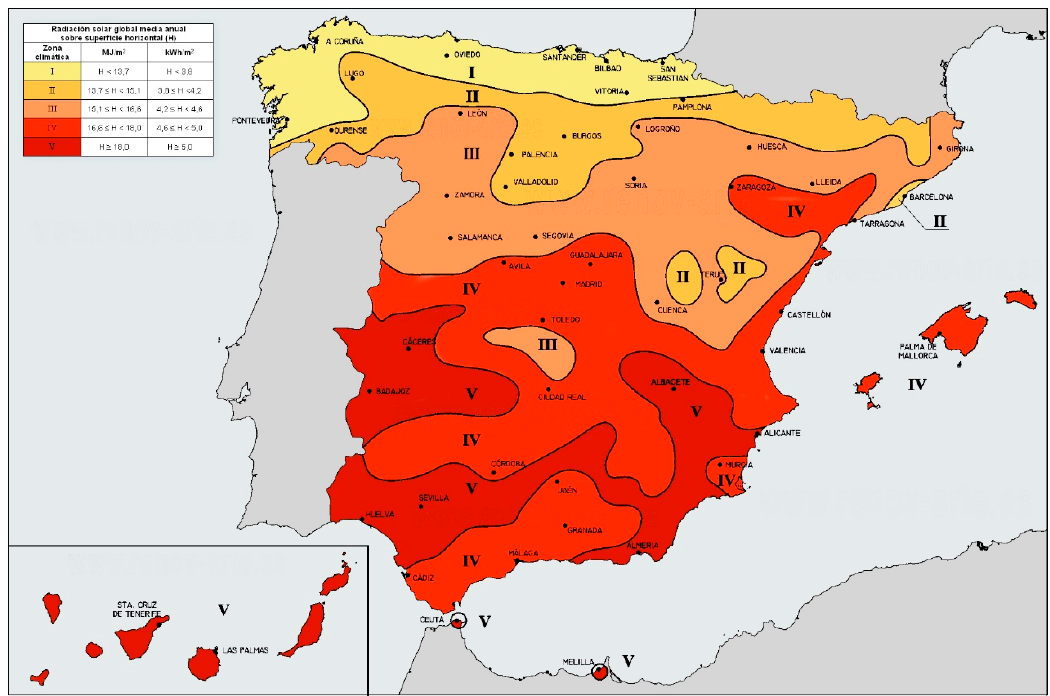
Figure 12. Solar climate zones according to the Spanish Technical Construction Code. Table 10. Annual average daily global solar radiation (H).